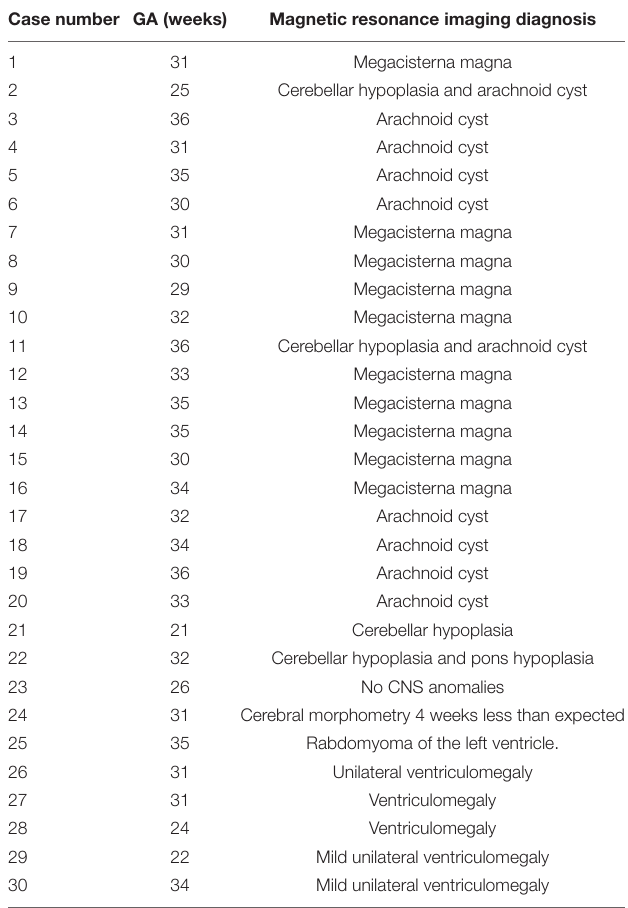
TABLE 1 | Cases used for the interobserver agreement study.